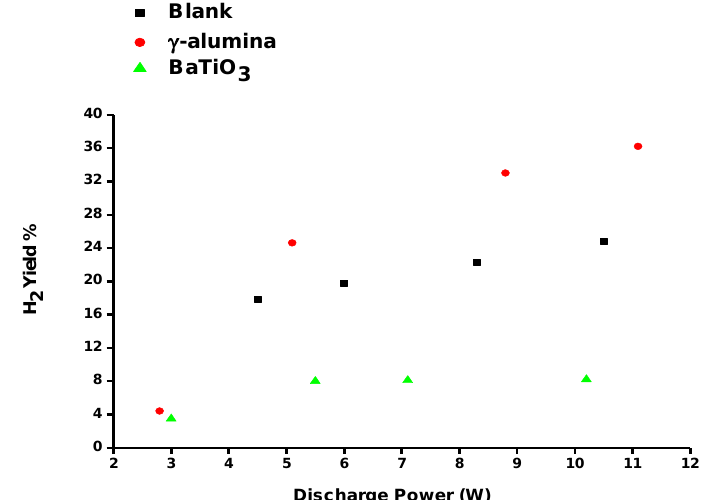
Figure 11. The conversion of methane as a function of discharge power for the reactor packed with BaTiO 3 and γ- alumina and the blank reactor.